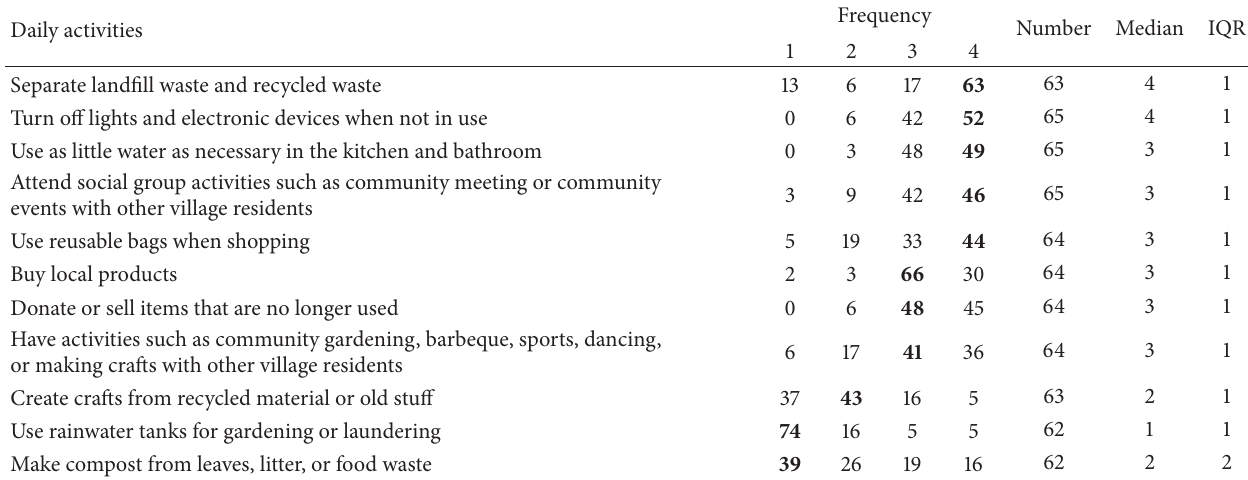
Table 3: Percentage of respondent carrying out sustainability activities.